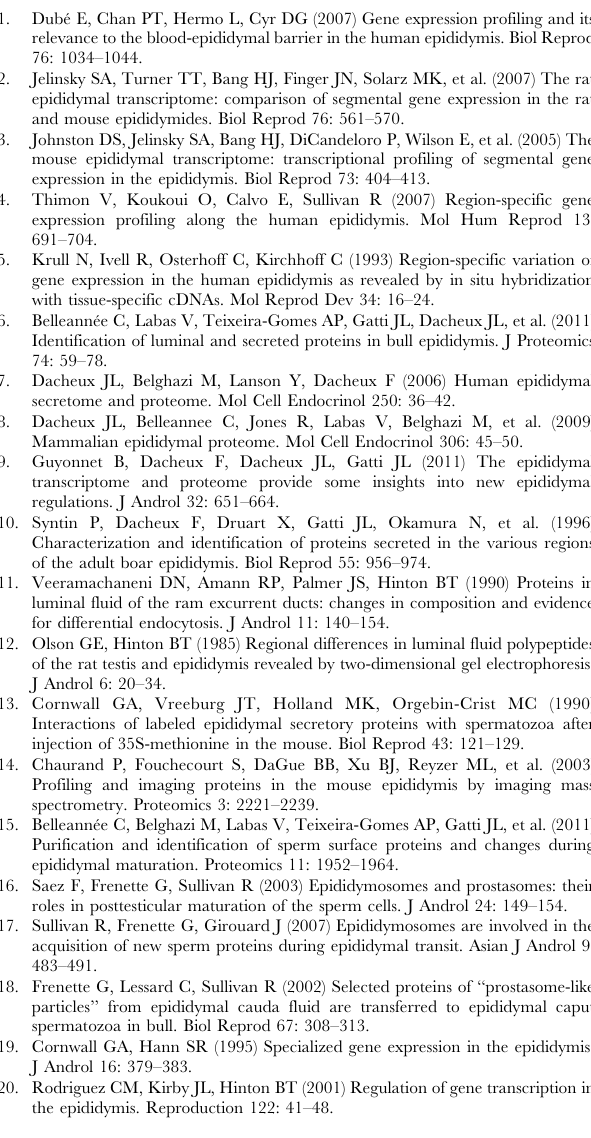
Figure S3 Negative correlation between selected miR- NAs and their predicted mRNA targets. Data represent the Log 2 expression found in the different segments of the epididymis (Caput, corpus and Cauda). Data are means 6 SEM. Figure S4 Positive correlation between selected miR- NAs and their predicted mRNA targets. Data represent the Log 2 expression found in the different segments of the epididymis (Caput, corpus and Cauda). Data are means 6 SEM. Table S1 List of miRNAs with a mean Log 2 signal intensity above the threshold of 3.2 in the